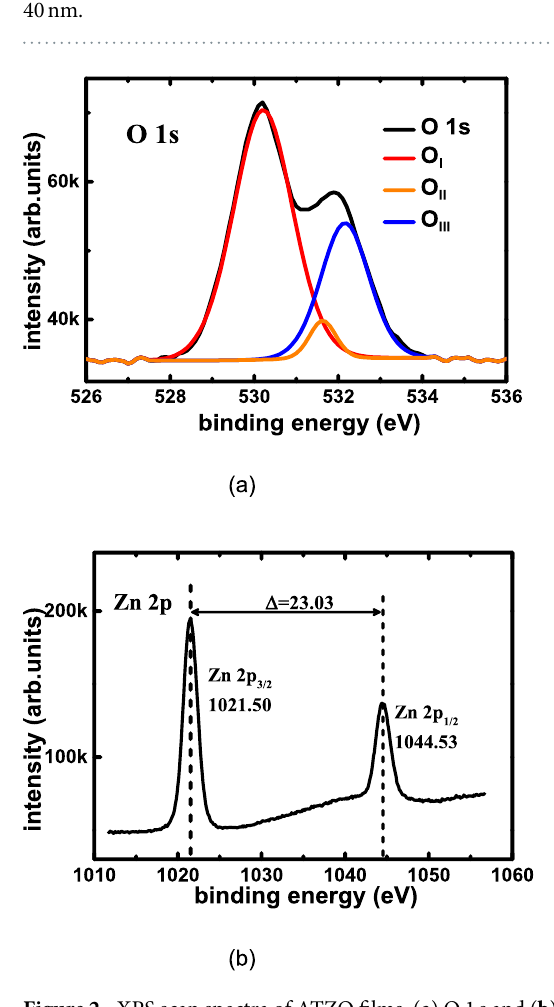
Figure 1. XRD scan spectra of the ATZO films with 15% oxygen partial pressure. The thickness of the films is 40 nm.